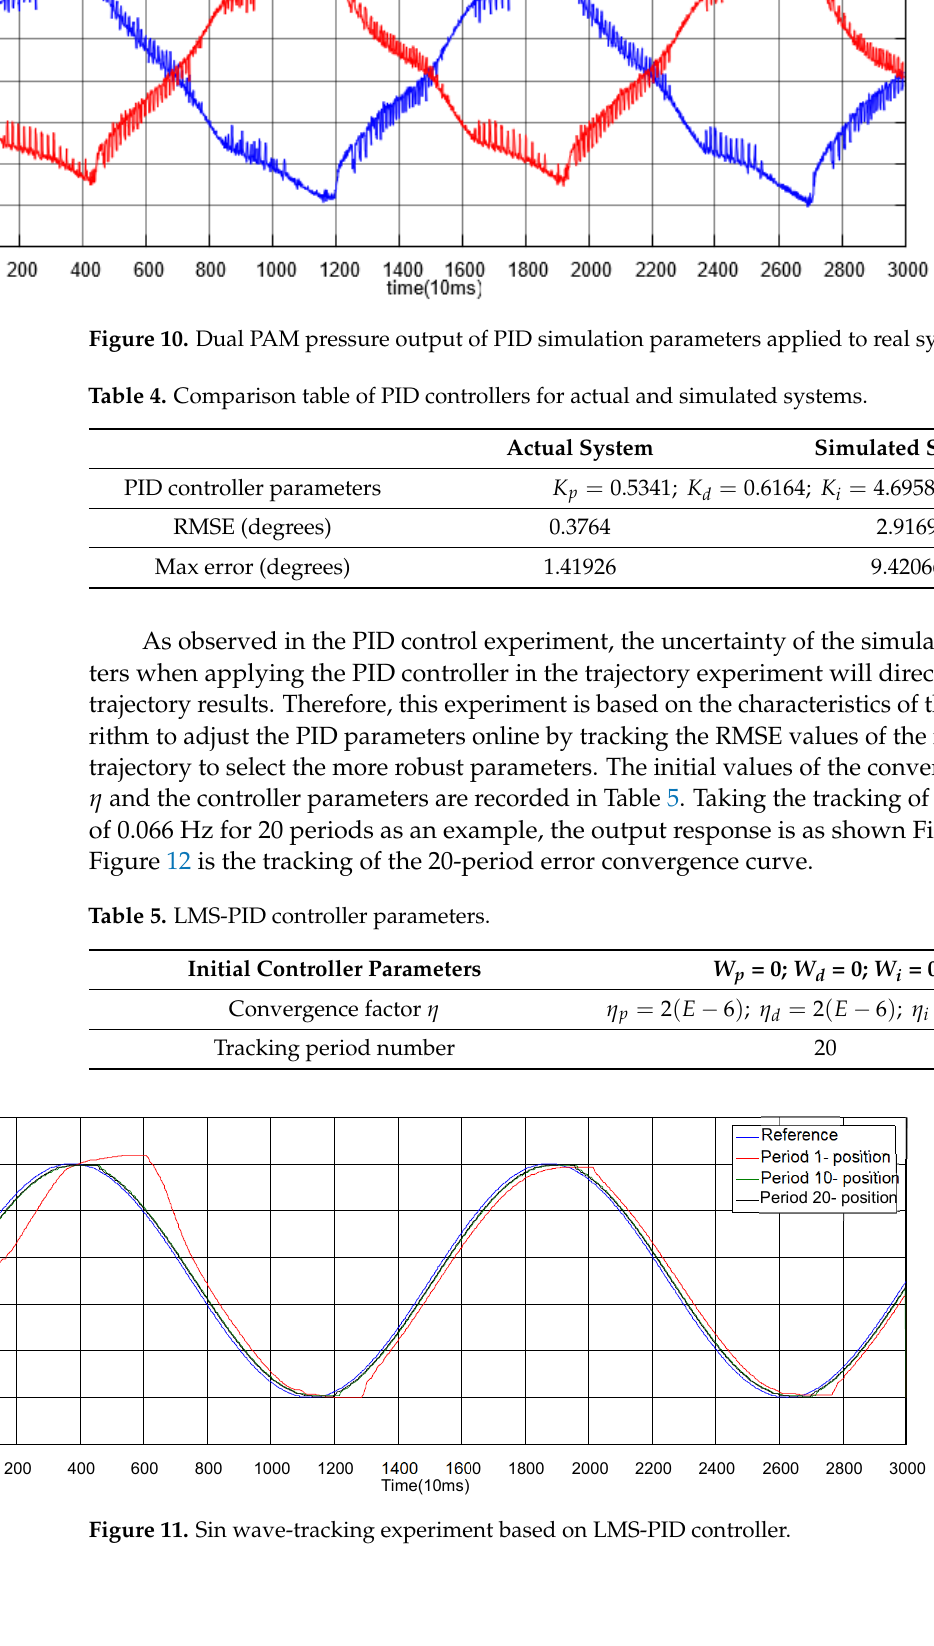
20 Figure 12. RMSE convergence curve based on LMS-PID tracking control. Hence, compared to a PID controller that adjusts each parameter one at a time to obtain better tracking results, self-adaptive PID controllers provide a more convenient way to obtain a set of controller parameters in feedback, and the parameters of the self- adaptive PID controller are variable in nature. Theoretically, it is more robust than the fixed parameters. In the adaptive PID controller, the convergence factor  has a significant effect on the convergence of the system response. The following experiment was conducted to ad- just the size of the convergence factor of the proportional parameter to observe the effect on the output response of the system under different convergence factors. The parameter settings are shown in Table 6. 1